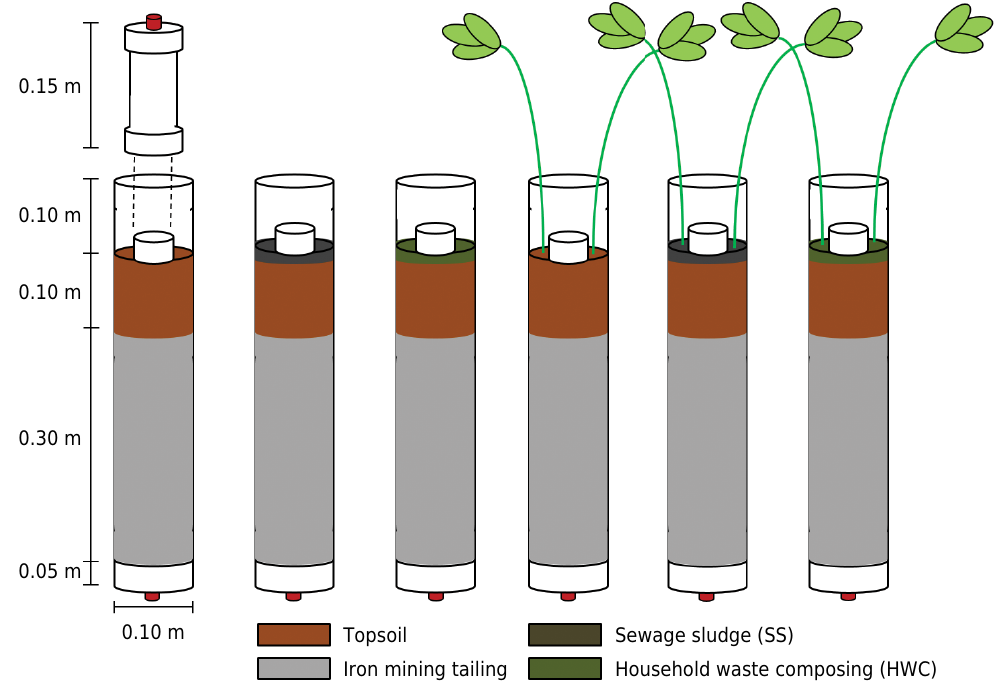
Figure 1. Scheme of experimental units (PVC columns) with the iron mining tailing, topsoil, sewage sludge (SS) or household waste composting (HWC), and plants ( Crotalaria juncea ). The PVC chambers (0.10 × 0.05 m of height and diameter, respectively) were installed centrally on the soil surface, while PVC caps (0.15 × 0.05 m of height and diameter, respectively) fitted with a central rubber septum were used to collect the